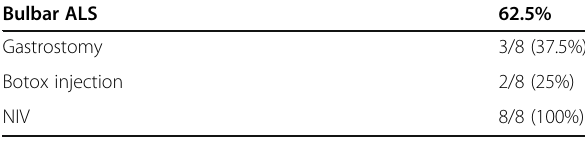
Table 3 Intervention for patients with declining ALSFRS-R Bulbar